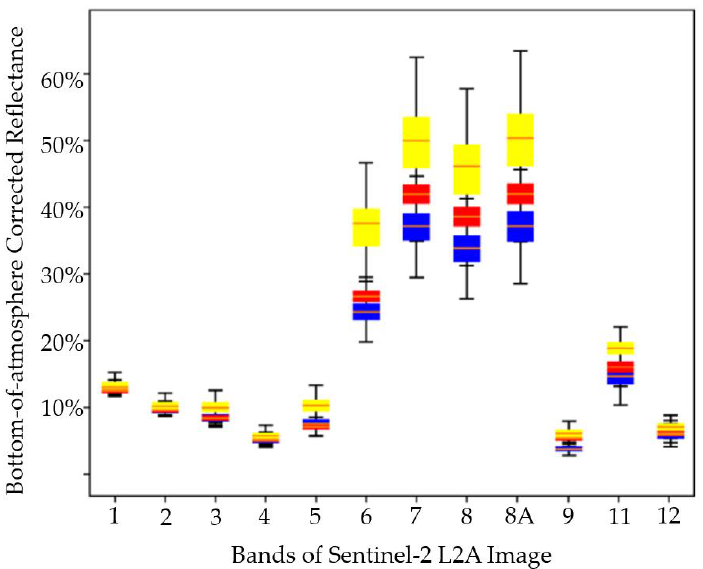
Figure 8. Reflectance of corn, peanut, and rice in different bands of Sentinel-2 images. Red represents corn, yellow represents peanut, and blue represents rice.